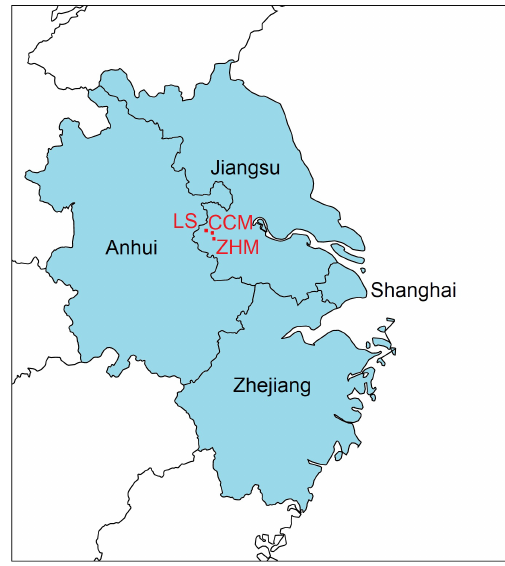
Figure 1. The simulation domain. The blue area indicates the YRD including Jiangsu, Anhui, Shanghai, and Zhejiang. Three represen- tative sites of Caochangmen (CCM), Zhonghuamen (ZHM), and Laoshan (LS) are